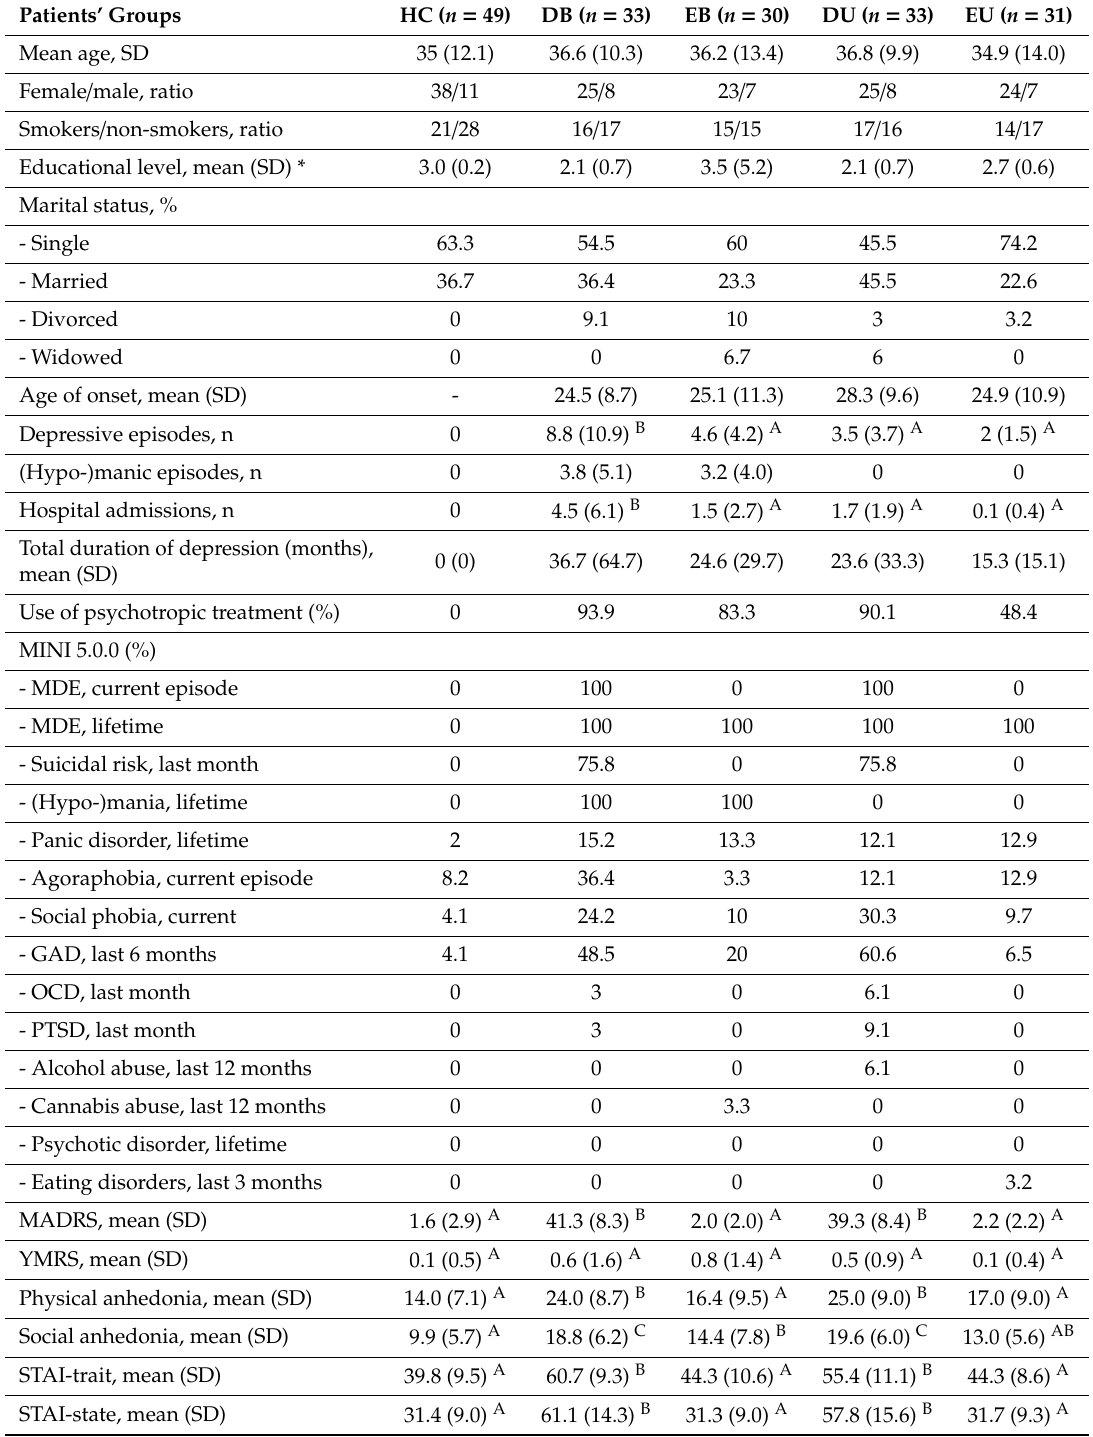
Table 1. Demographic and clinical characteristics of the